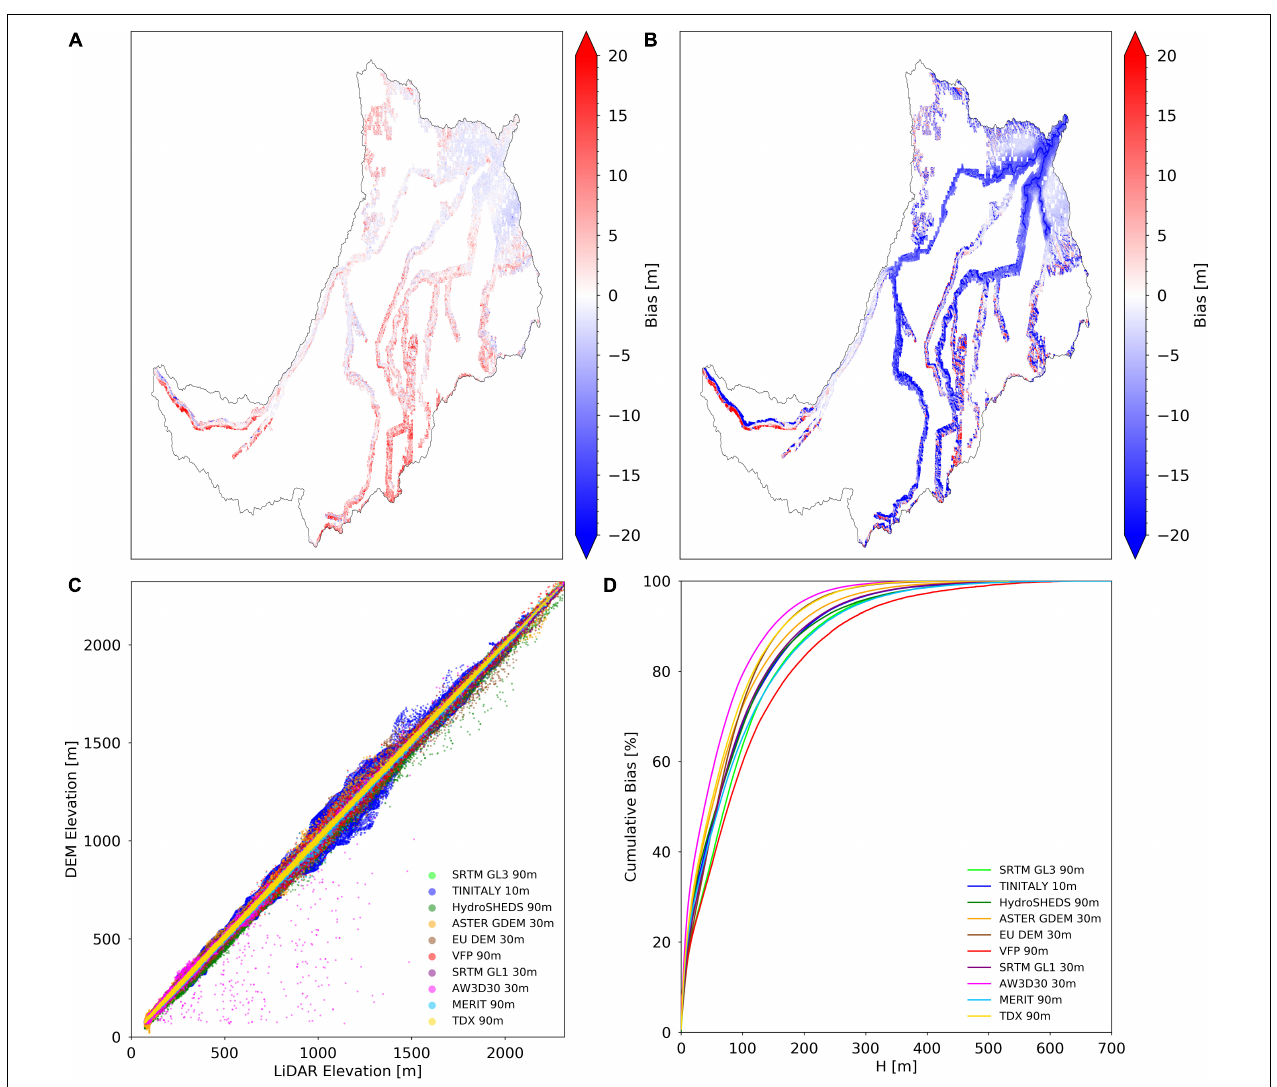
FIGURE 6 | (A) Map of statistical bias between the SRTM GL3 digital elevation model (DEM) and the light detection and ranging (LiDAR) data in the Tanaro river basin, Italy; (B) map of statistical bias between the HydroSHEDS DEM and the LiDAR data; (C) DEM elevations plotted against LiDAR elevations; (D) cumulative frequency of absolute BIAS plotted against the elevation difference to the nearest stream,